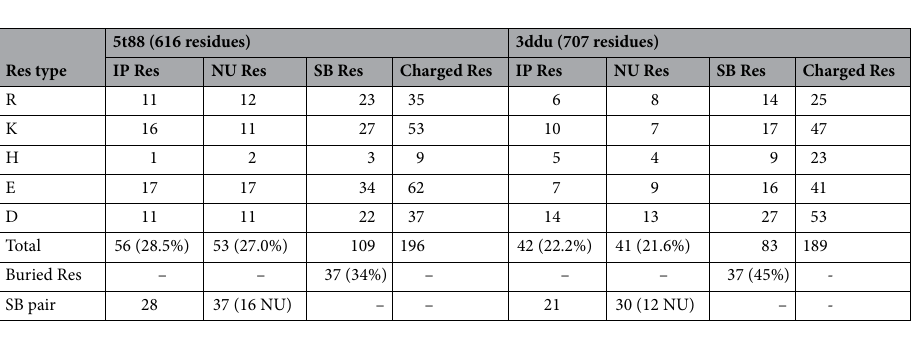
Table 1. Salt-bridge forming residues constitute only about half of the total charged residues. Absolute frequency of isolated pair residue (IP Res), network unit residue (NU Res), and charged residue of 5t88 (left) and 3ddu (right). Total salt-bridge residues (SB Res) is the sum of IP Res and NU Res. The buried residue (Buried res) is the buried residues.